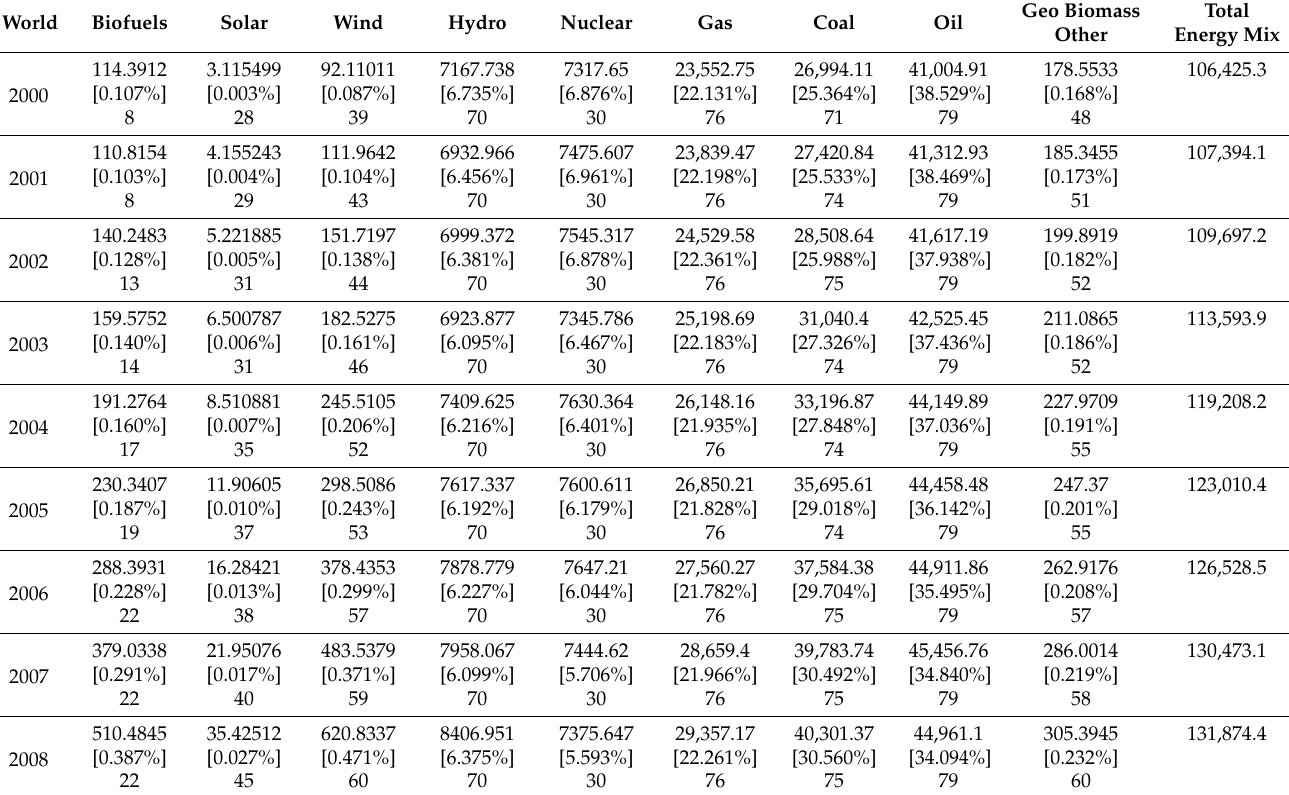
Table A1. Energy Mix by source (all in